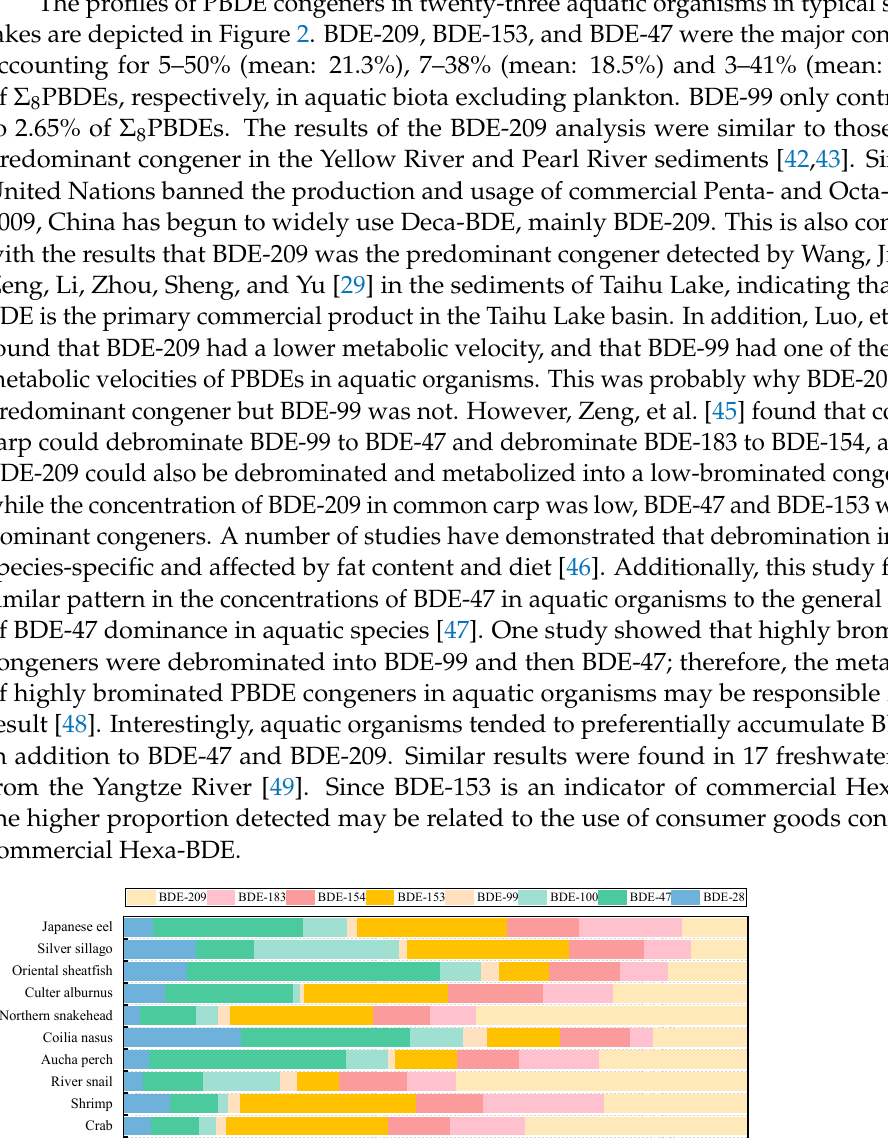
Table 2. BCF, BSAF, log Kow, slope and p-value of the slope of the regression analysis between the natural logarithm of concentration and TLs, and TMFs for PBDE congeners in aquatic organisms collected from typical shallow lakes. Log Kow of PBDEs were referenced from the U.S. EPA . PBDE